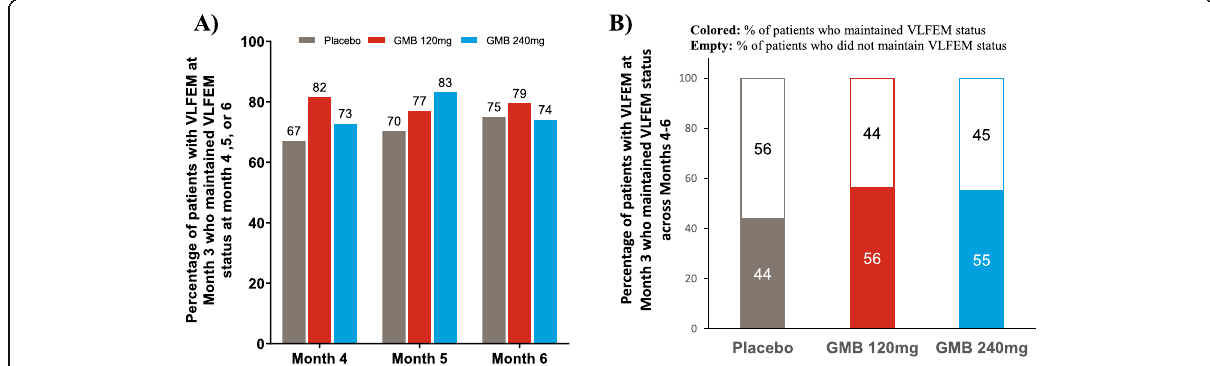
Fig. 2 Percentage of patients who achieve VLFEM at Month 3 and ( a ) maintained VLFEM status at each of Months 4, 5 or 6, ( b ) maintained VLFE M status across Months 4, 5 or 6. Abbreviations: CI, confidence interval; GMB, galcanezumab; HFEM, high-frequency episodic migraine; n, number of patients who were categorized as HFEM at baseline with a baseline value and at least one post-baseline value recorded; OR, odds ratio; VLFEM, very low-frequency episodic